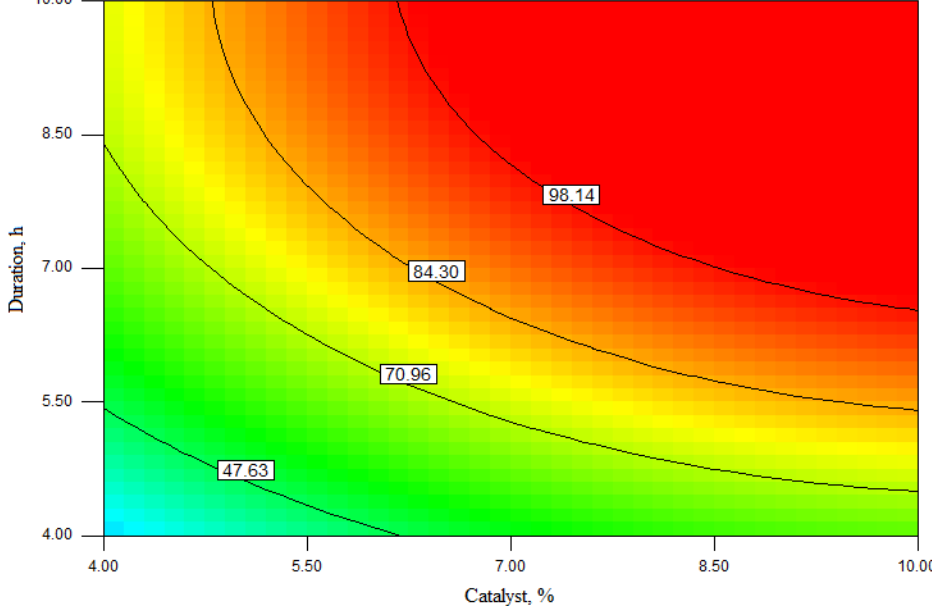
Figure 3. Response surface contour plot for the interaction between the process duration and the catalyst amount for the ester yield (the methanol-to-oil molar ratio is 10:1).